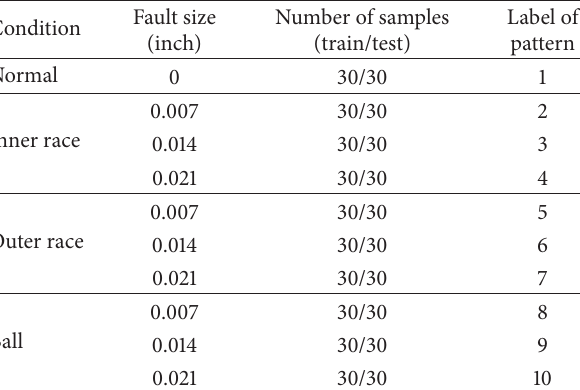
Table 1: The description of the bearing